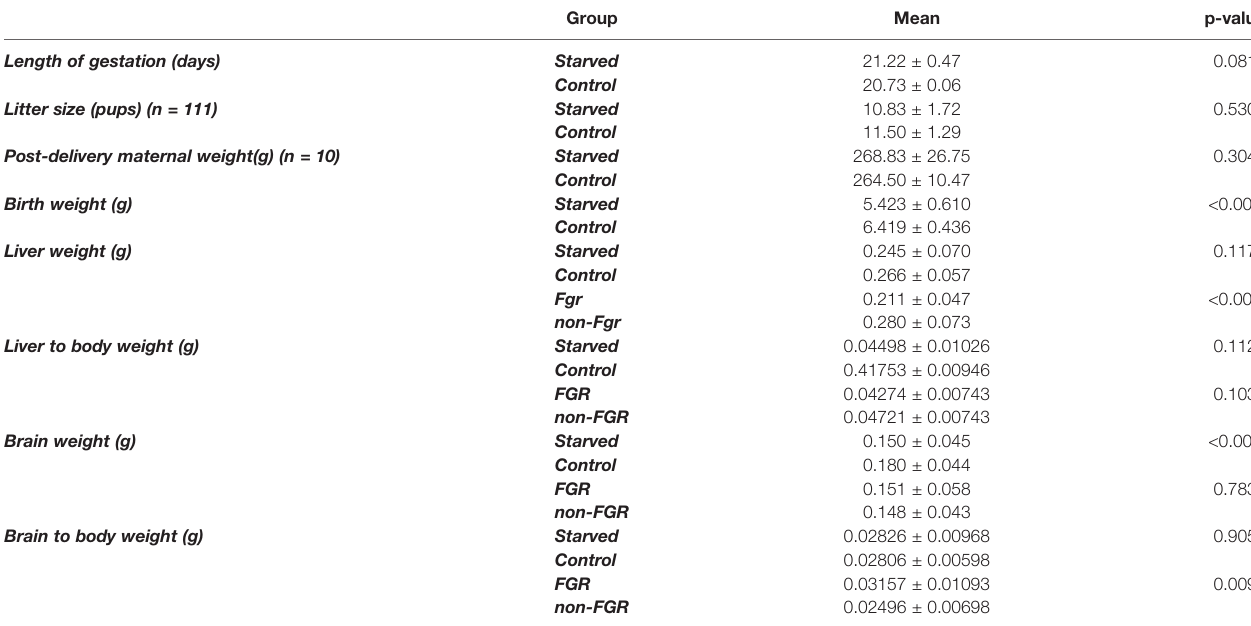
TABLE 1 | Mean values for all experimental outcomes and comparisons between study